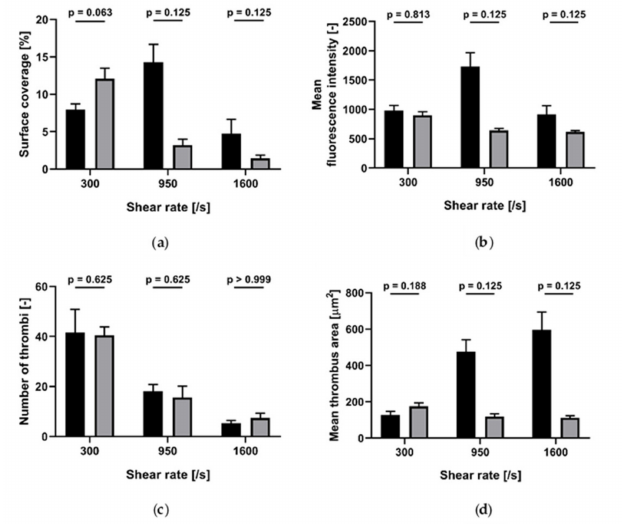
Figure 6. E ff ect of cangrelor at di ff erent shear rates on platelet accumulation on collagen (10 µ g / mL)-coated perfusion chamber ( n = 5). Black: without cangrelor; grey: with cangrelor added in vitro. ( a ) Surface coverage; ( b ) mean fluorescence intensity; ( c ) number of thrombi; ( d ) mean thrombus area. Data are represented as column bar graphs, with means ± standard errors of the mean, and analyzed by Wilcoxon matched